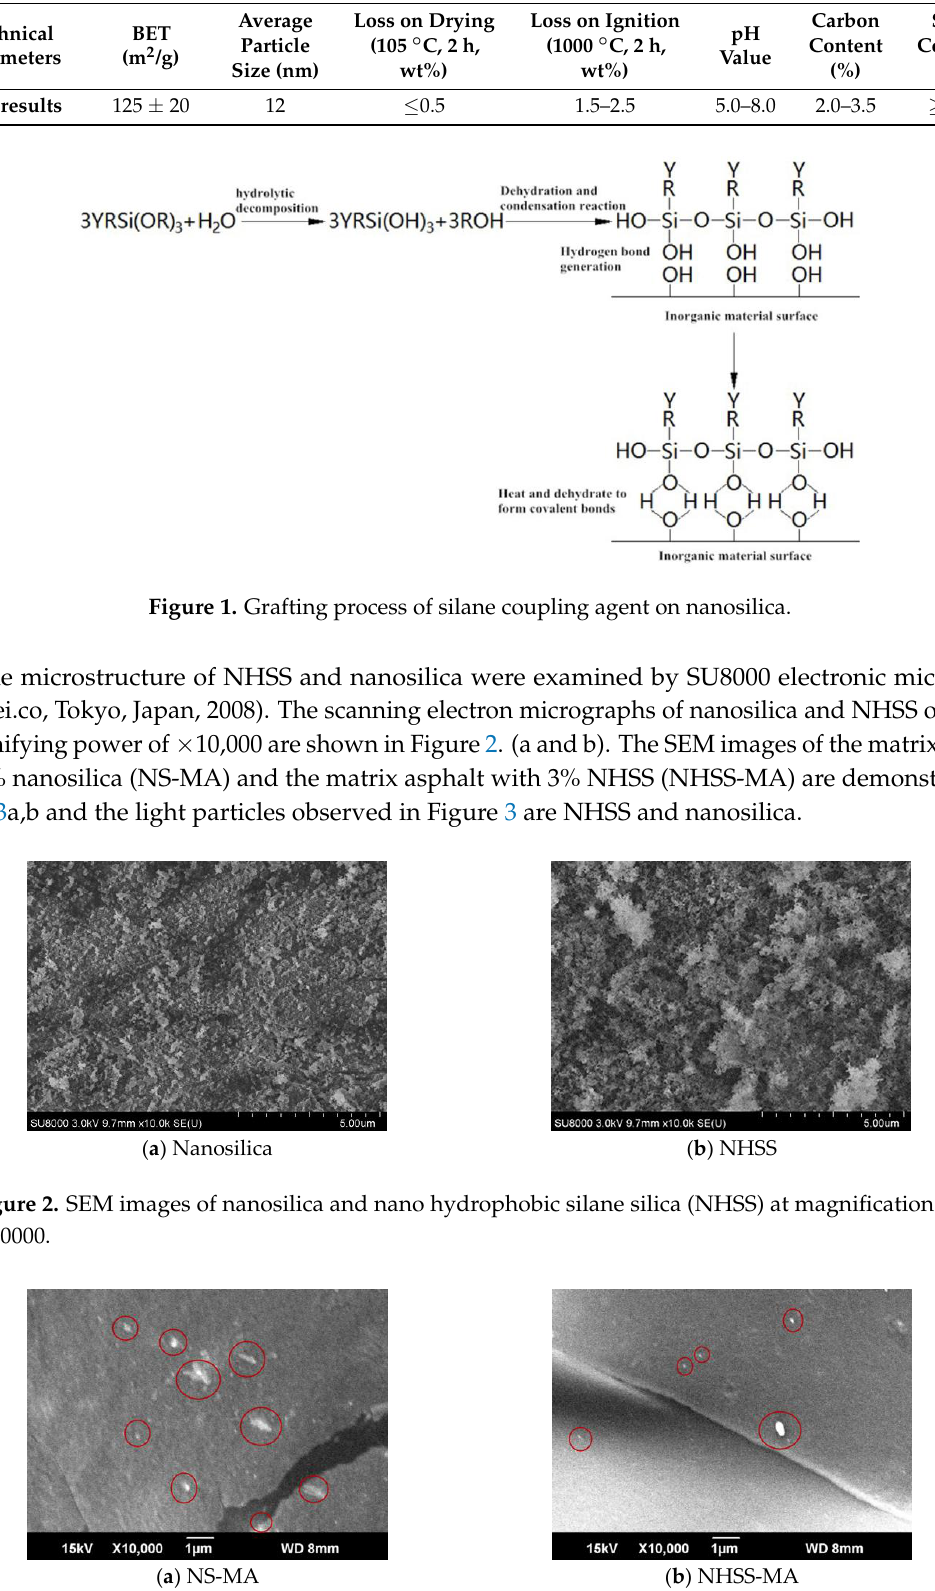
Table 3. Technical parameters of nano hydrophobic silane silica (NHSS).